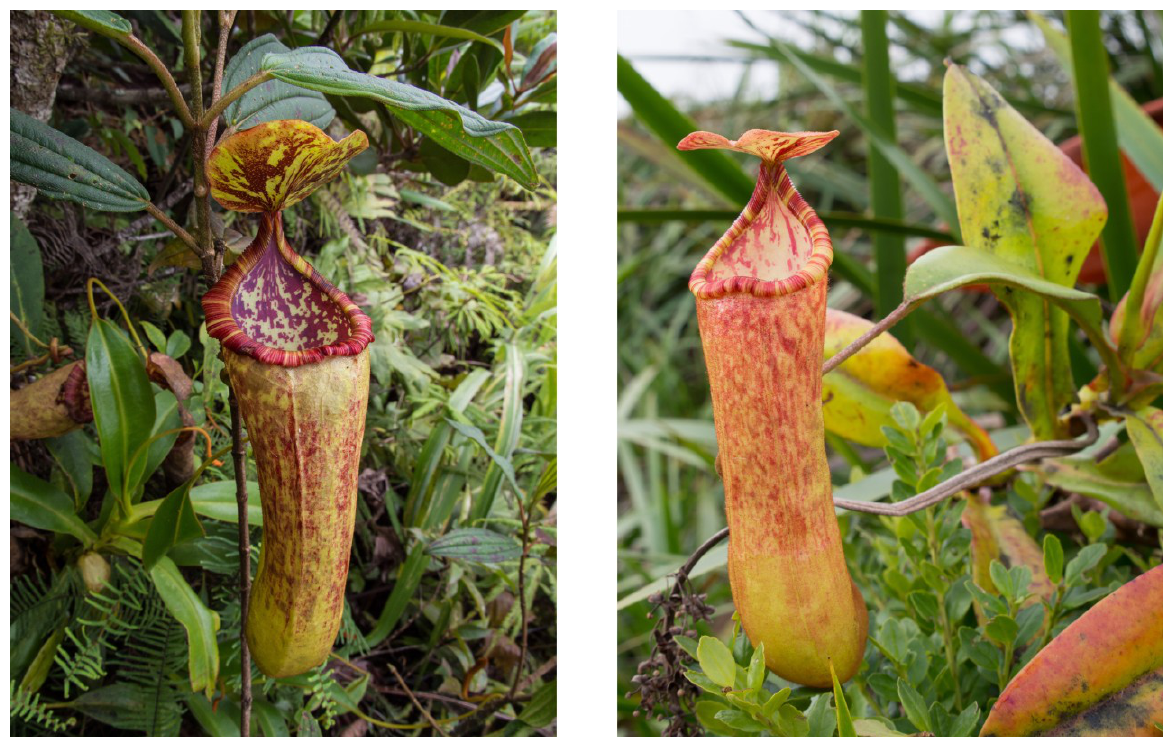
Figure A4. N. amabilis : photos of two pitchers taken at the type locality. In the left panel, the distinct leaf shape can be